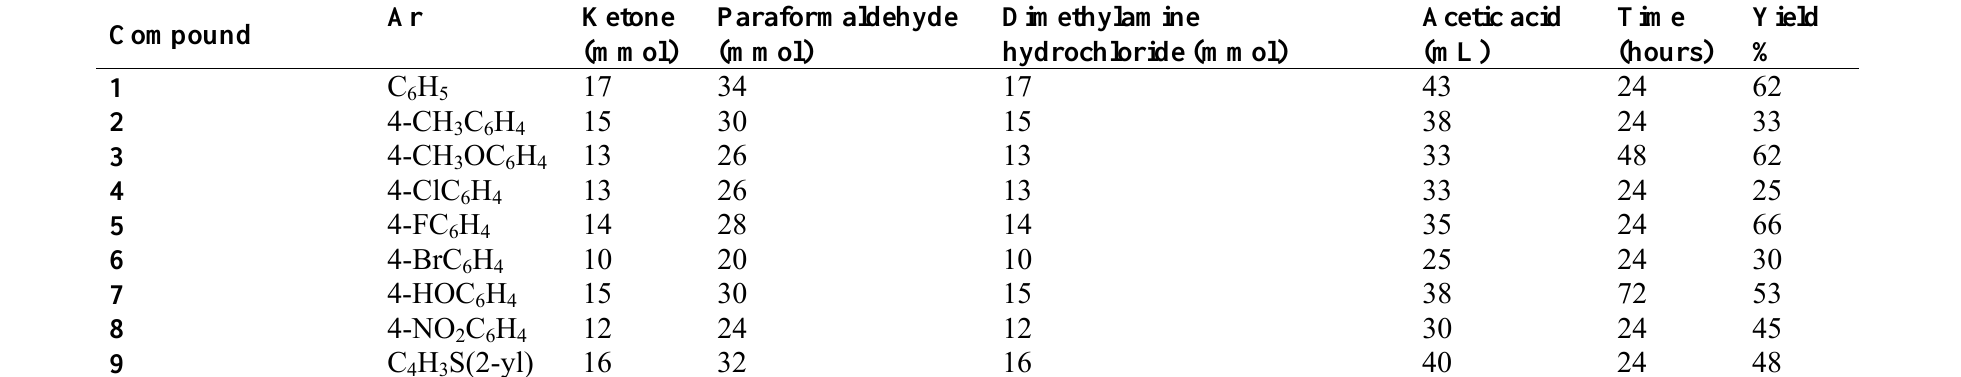
Table 1. Physical data of the reactions by conventional method.